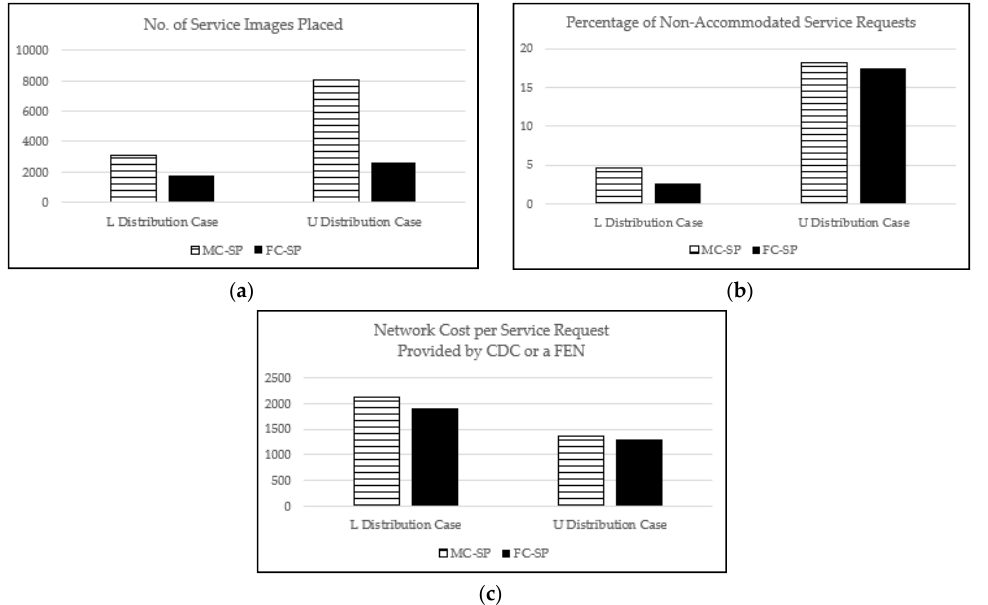
Figure 14. The performance comparision of the L distribution case and the U distribution case with the maximum CDC capacity of 500 and 1000 service types: ( a ) the number of service images placed; ( b ) the number of non-accommodated service requests; ( c ) the network cost per service request provided by CDC or a